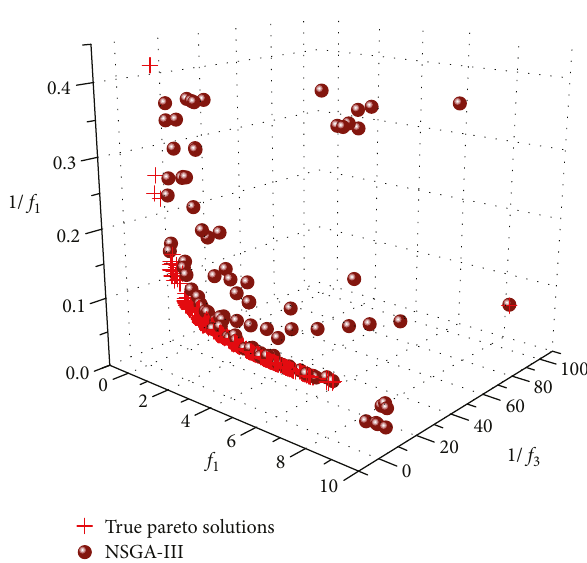
Figure 5: Plots of the true PSs and the fi nal PSs found by NSGA-III on the speci fi c instance.